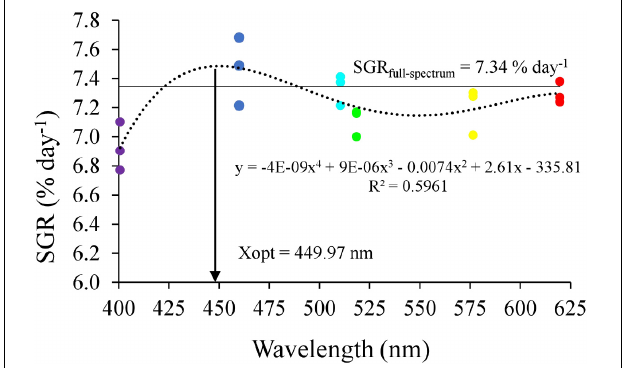
FIGURE 3 | Relationship between light wavelength and specific growth rate (SGR) in mud crab based on 4-SKM. The horizontal line represents as SGR of F